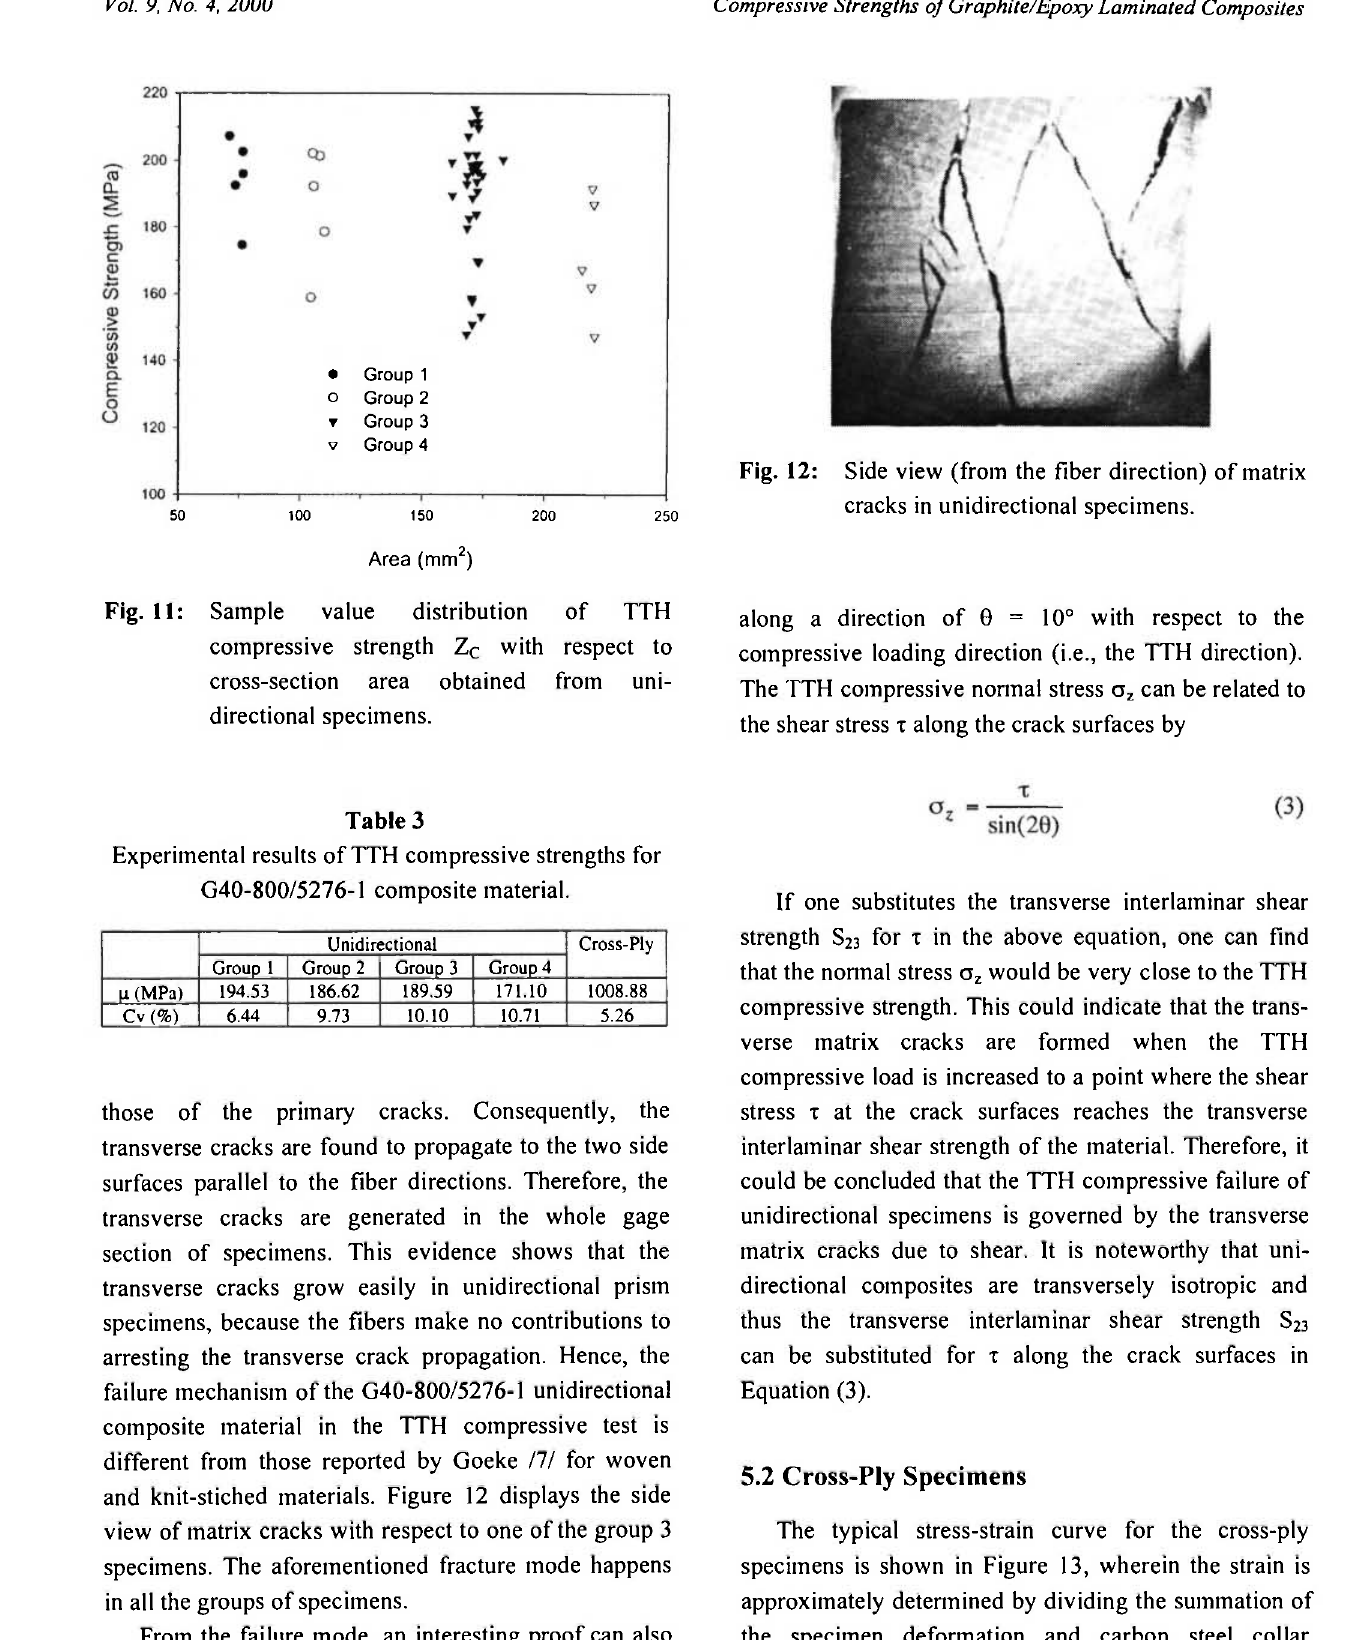
Fig. 12: Side view (from the fiber direction) of matrix cracks in unidirectional specimens.